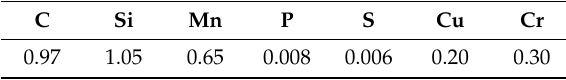
Table 1. Chemical components of samples (wt.